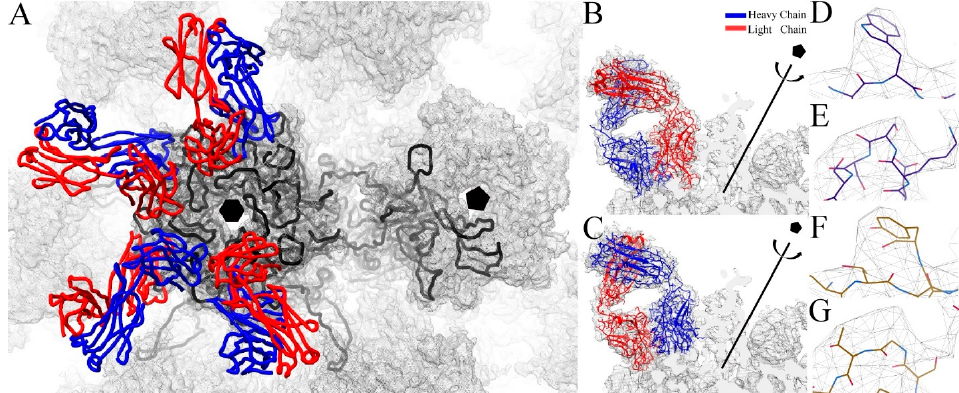
Figure 3. V5 Fab and L1 protein structures. ( A ) The asymmetric unit used for refinement includes six L1 proteins (black wire), five L1 from the hexavalent (black hexagon) and one L1 from the pentavalent (black pentagon) capsomers and four V5 fabs with heavy chain (blue) and light chain (red) shown in wire. V5 Fab was built in both possible orientations; ( B ) with heavy chain (blue ribbon) facing outward from the center of the capsomer and ( C ) with the light (red ribbon) chain facing outwards. Close up views show the fit of specific residues that aided in the identification of the correct binding mode; ( D ) the side chain of 59H.TRP fitted well into the density of the heavy chain outwards build; however light chain outward placed 59L.TYR into the same density and a poor fit; ( F ) similar results were also observed for H74-H77 residue sequence in heavy chain facing out mode ( E ) compared to the light chain facing out mode ( G ) of unfilled density.